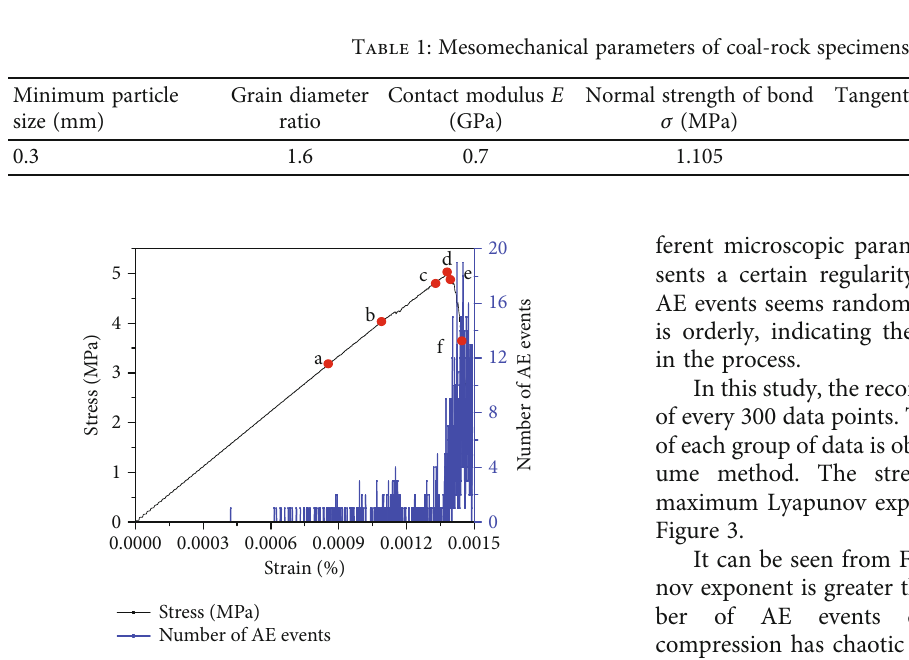
Figure 1: Stress-strain-AE event number variation curve of coal